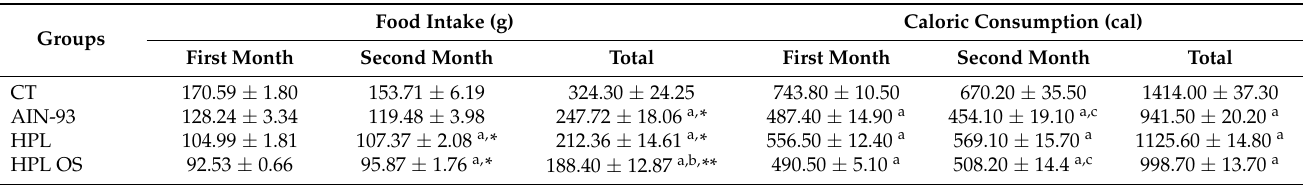
Table 2. Food consumption (grams) and caloric intake (calories) in different periods of the experiment (first month, second month, and total period) of animals fed a balanced or high-fat diet supplemented with saline, soybean oil, olive oil, or seed oil of papaya ( Carica papaya Linn).